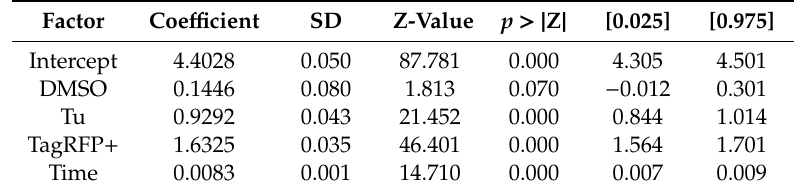
Table 3. Results of Poisson GEE Regression with Autoregressive Covariance Structure 1 . Factor Coe ffi cient SD Z-Value